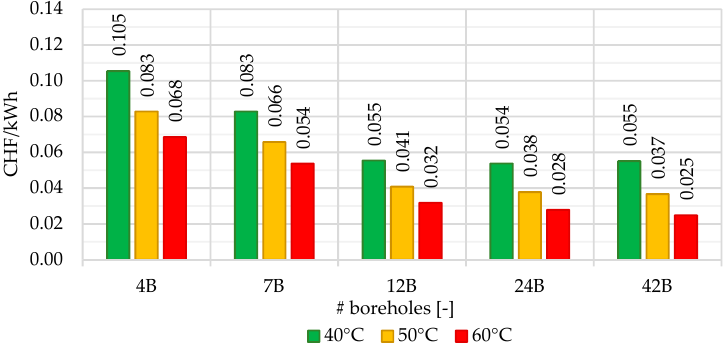
Figure 32. LCOS for each configuration and charging temperature.